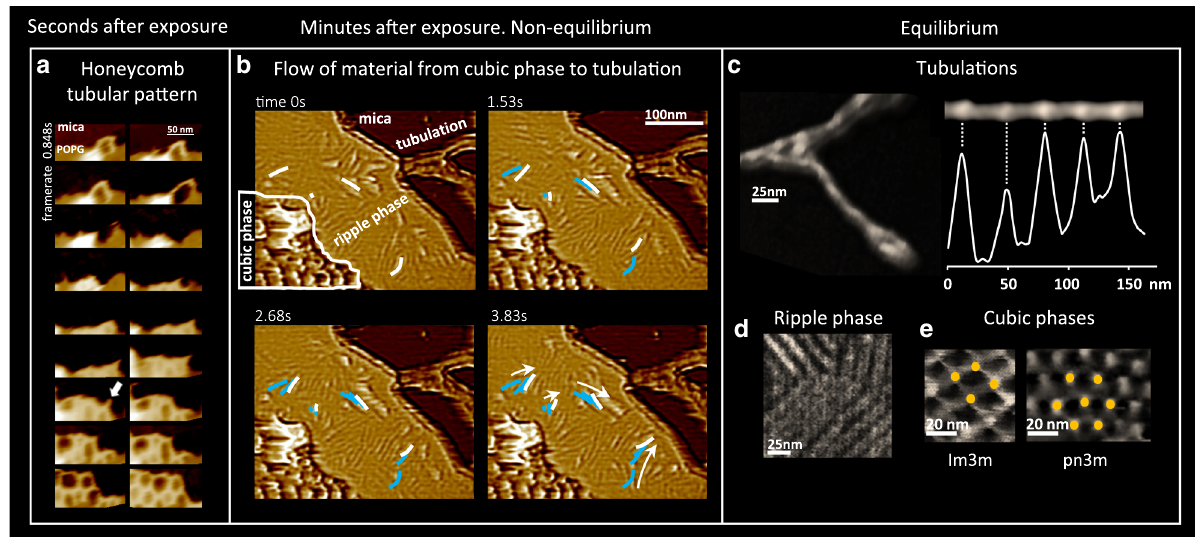
Fig. 6 Over-MIC Dap on POPG at 37 °C. a The fi rst seconds after exposure to over-MIC Dap, at the POPG membrane border tubules of diameter of ~15 nm branch in hexagonal directions (arrow) and create in seconds a tubular honeycomb structure. Movie details: frame rate 848 ms; zoom of a full image of 150 nm × 90 nm and 256 × 160 pixels (colour scale: 16 nm). b Minutes after exposure, the POPG membrane showed an heterogenous and dynamic environment where different regions of the membrane showed different Dap-induced deformations and where material fl owed from region to region (low passed fi ltered images to highlight the contrast are shown). The fl ow of material, observable on a zone of ripple phase of 15 nm pitch (please note that